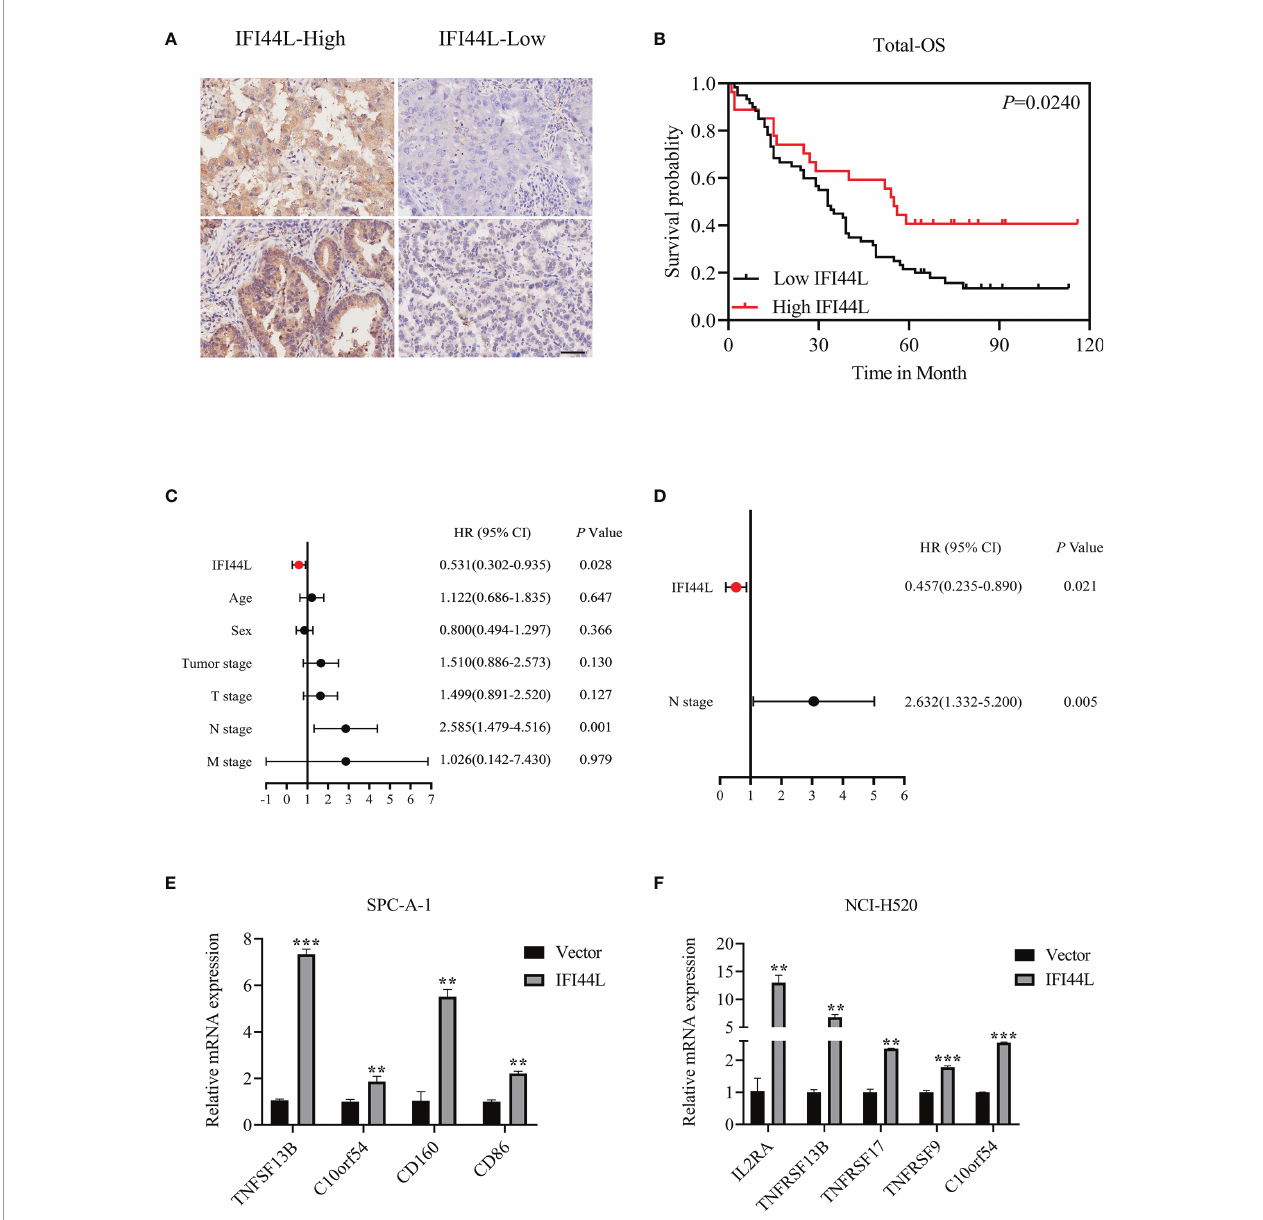
FIGURE 11 | Veri fi cation of the prognostic value and immune implication of IFI44L in NSCLC. (A) Representative IHC images of IFI44L in TMA cohort with the scale bar equal to 50 µm. (B) The correlation of IFI44L expression with OS among 97 NSCLC patients. (C) Univariate Cox regression analysis regarding the expression of IFI44L and other clinical parameters. (D) Multivariate Cox regression analysis about the expression of IFI44L and clinical parameters. (E, F) The expression levels of the related immunomodulators were detected in NSCLC cells after overexpression of IFI44L . NSCLC, non-small cell lung cancer; OS, overall survival; LUAD, lung adenocarcinoma; IHC, immunohistochemistry; TMA, tissue microarray; ** p < 0.01, *** p <